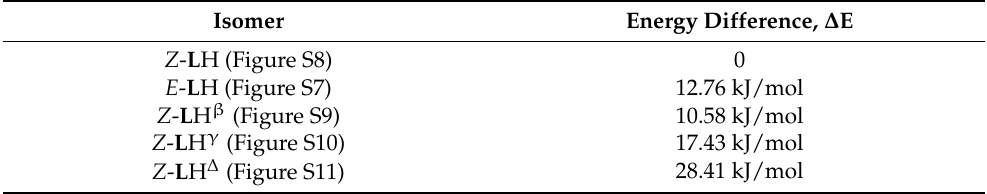
Table 2. Selected interatomic distances of 1 ∞ { [ Cu L Cl ] · 0.5H 2 O }